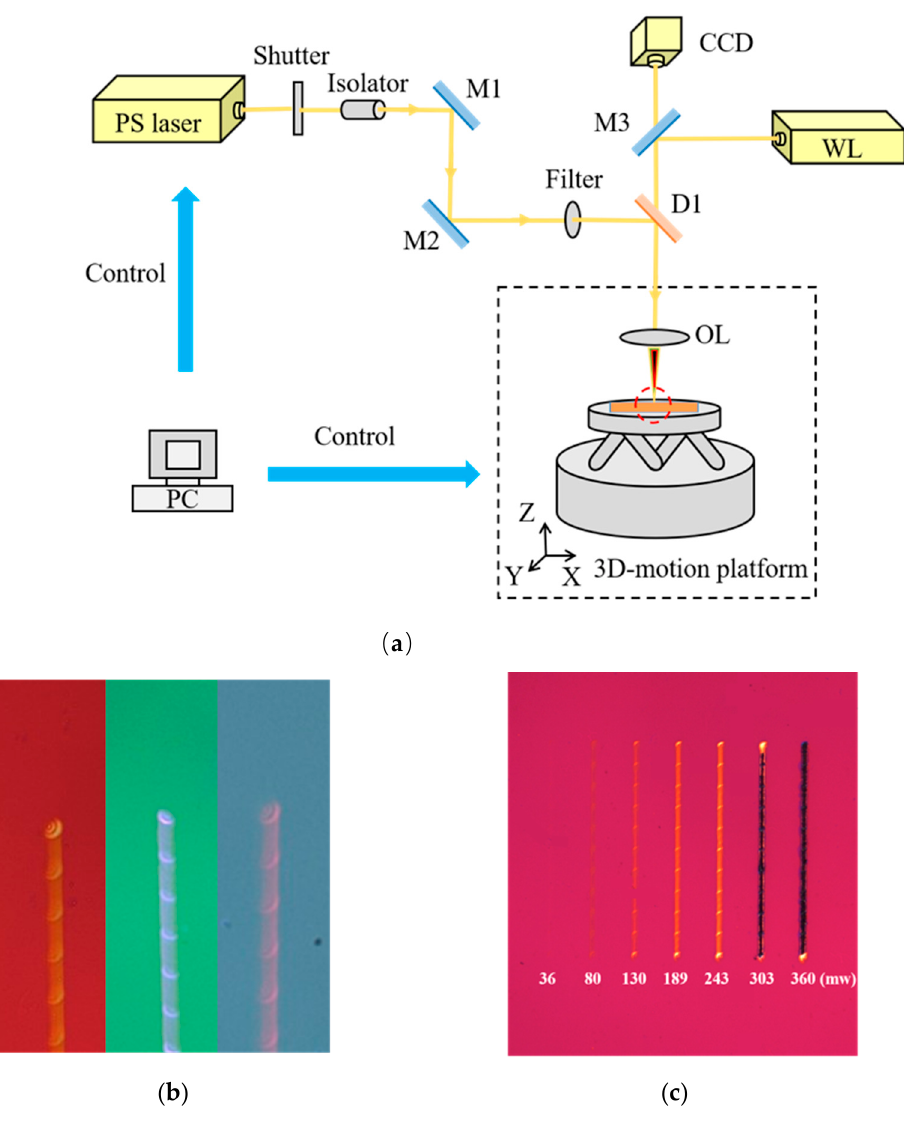
Figure 12. ( a ) Schematic diagram of the optical path of the picosecond laser; ( b ) laser scanning color for three primary color base plates; ( c ) color changes under different laser power.